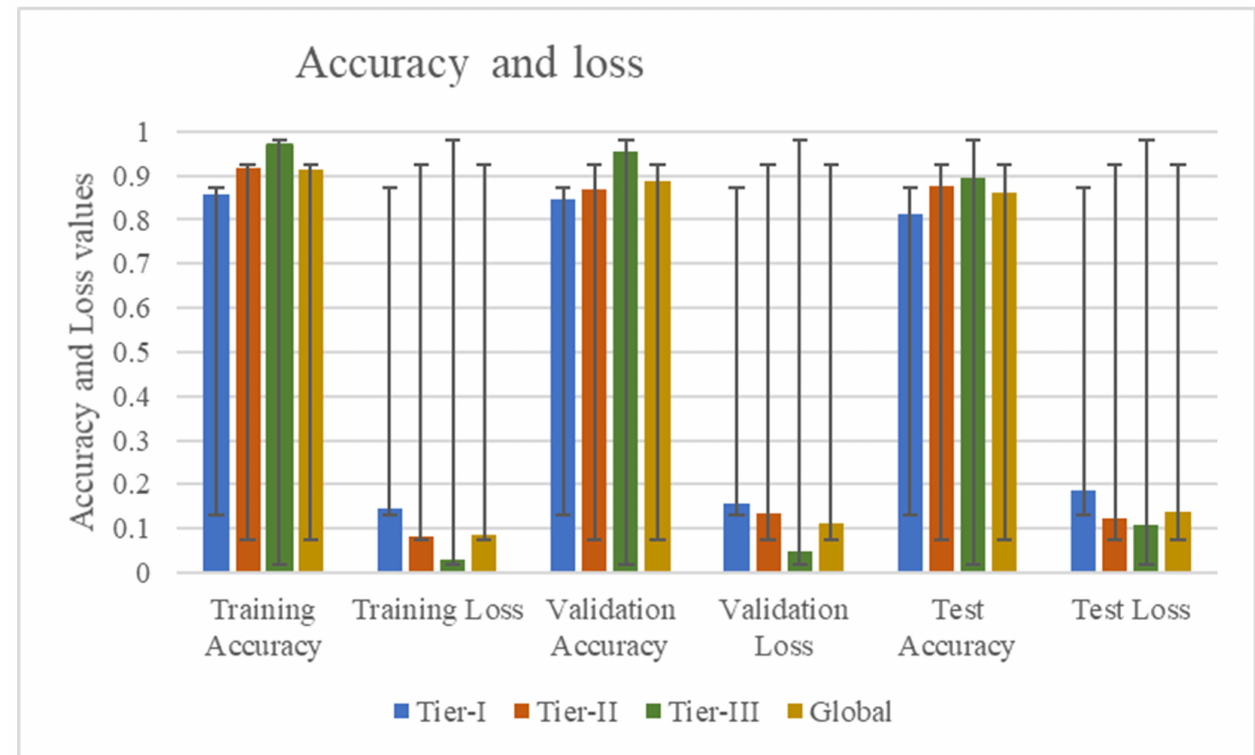
Figure 10. Comparison among individual and global training, validation, and test accuracies with relevant losses of all tiers. The error bars show the difference between accuracy and relevant loss values.